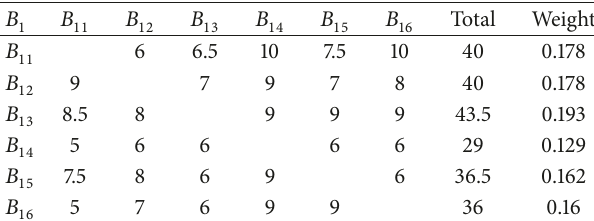
Table 11: Judgment matrix of 𝐵 1 − 𝐵 1𝑘 .